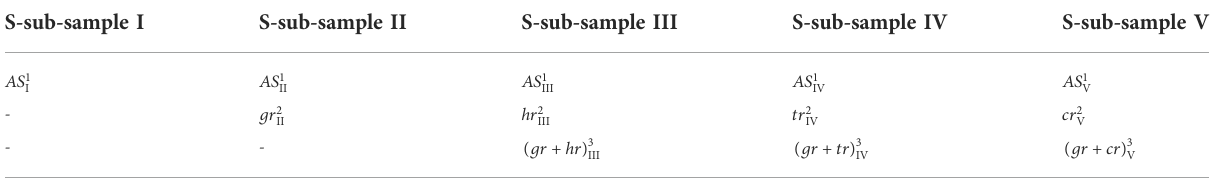
TABLE 1 Design ideas of the veri fi cation scheme for the quantitative scope embedding